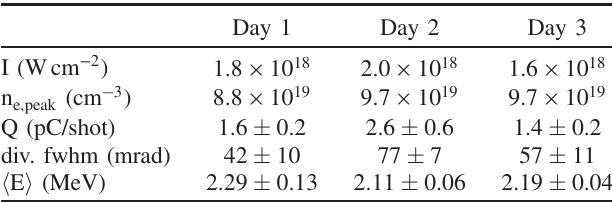
TABLE I. Various experimental parameters and electron beam performance showing slight variations from day to day but overall fair reproducibility of the experiment. The values after the (cid:2) sign are RMS deviation.